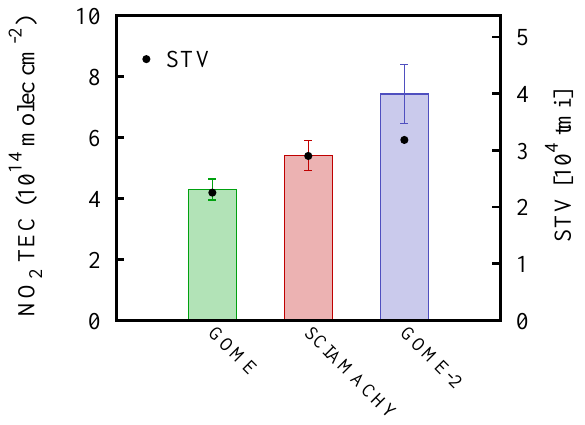
Fig. 5. Multiannual mean NO 2 tropospheric excess column (TEC) measured with satellite instruments GOME (1996–2003), SCIA- MACHY (2002–2008), and GOME-2 (2007–2008) over region S over the Indian Ocean. Errorbars are based on the estimate of the uncertainties excluding the AMF contribution which is assumed to be the same for all three data sets. In addition, the mean seaborne trade volume (STV) over the corresponding time periods is given ( • ).